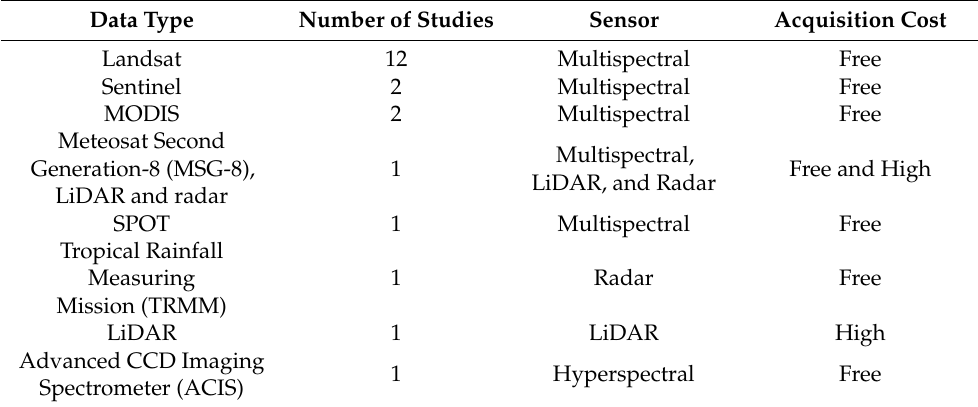
Table 4. Overview of the total number of studies, sensor type, and cost of the remote sensing data used in the top 20 articles cited in the application of remote sensing in mountainous environments.